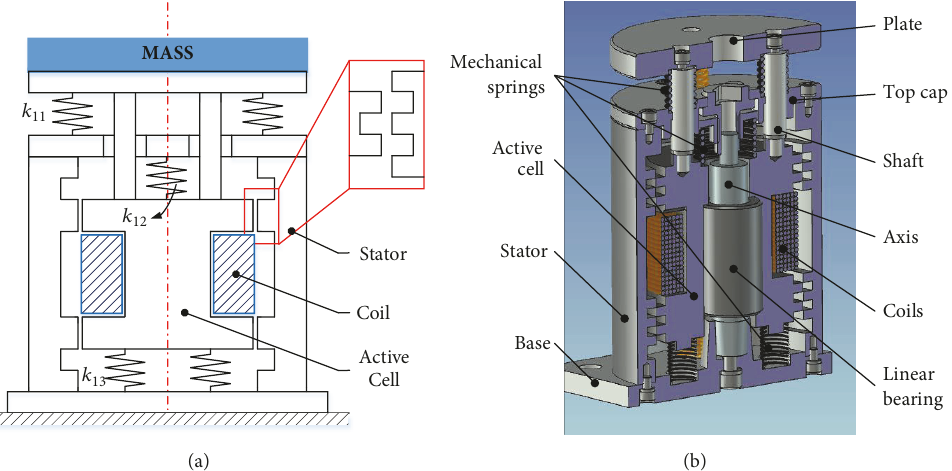
Figure 6: Scheme and 3D configuration of EVI: (a) schematic diagram and (b) 3D configuration.